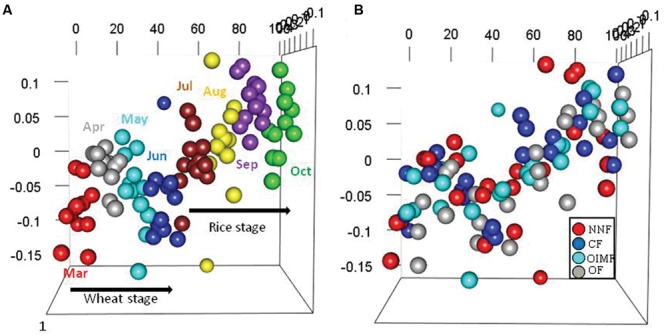
Bacterial structures under the four fertilization treatments at eight sampling stages in the wheat-rice rotation as analyzed by non-metric multidimensional scaling (NMDS) analysis based on phylum-level abundances. Plots colored with eight sampling stages (A) and four fertilization regimes (B) are displayed, respectively. The stress was 0.198, the non-metric fit R2 value was 0.961 and the linear fit R2 value was 0.897.